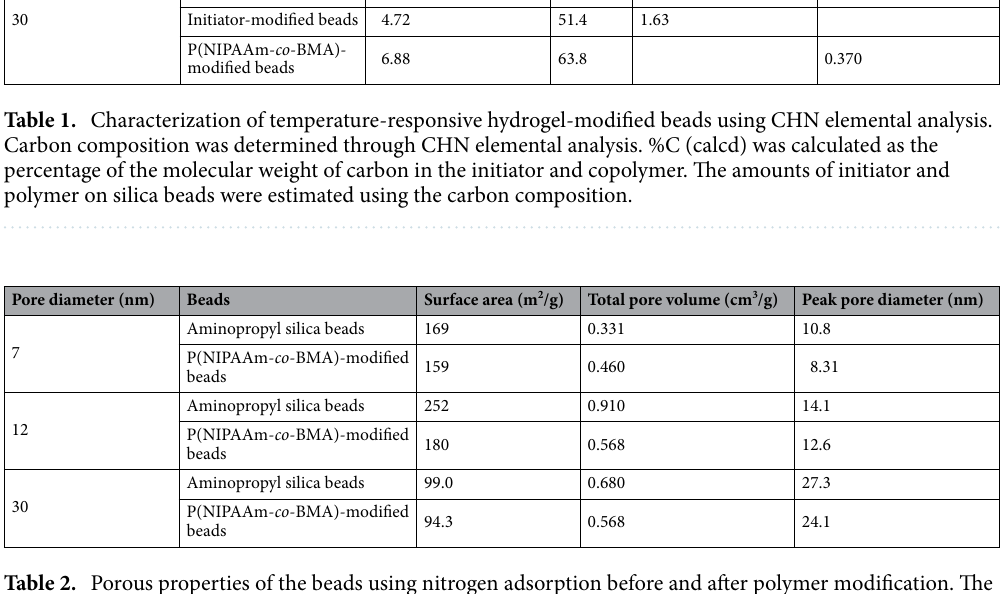
Table 2. Porous properties of the beads using nitrogen adsorption before and after polymer modification. The values were calculated using the Brunauer–Emmett–Teller (BET) method.